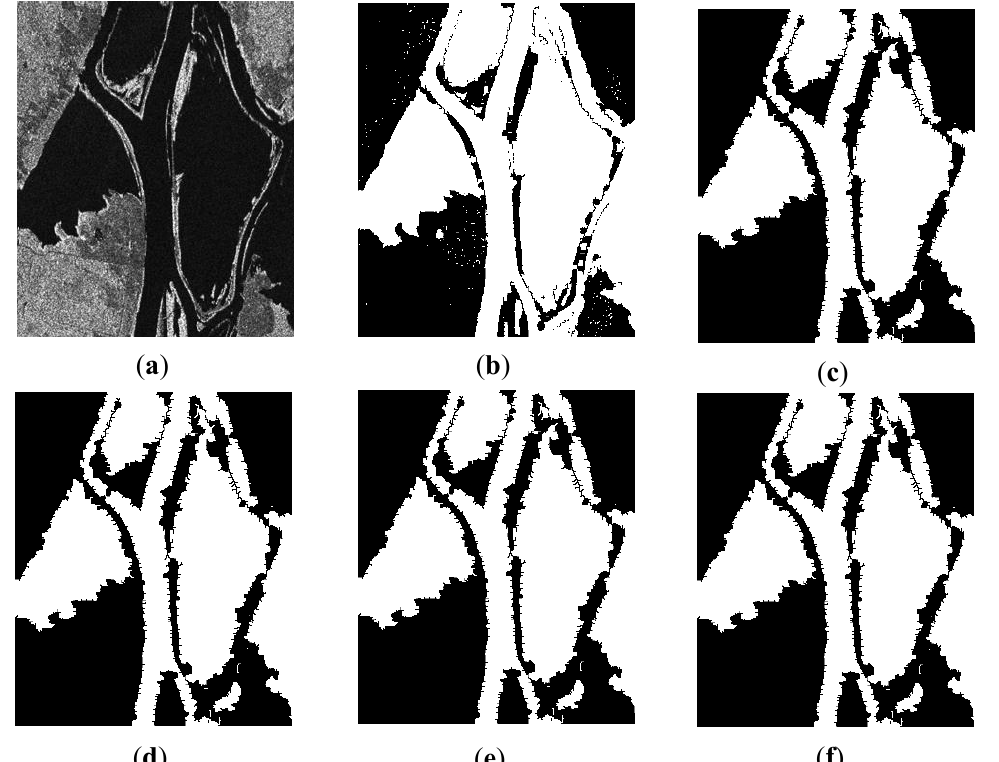
Figure 10. Segmentation results on SAR1. ( a ) original image; ( b ) AFWDLMO; ( c ) AFCMOMA;